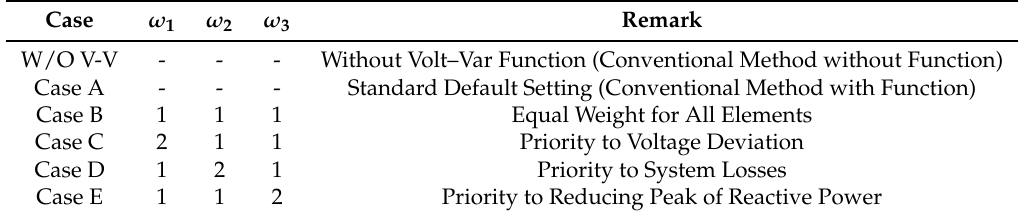
Figure 8. Case Comparison to verify the Improvement Effect on System Losses. Table 3. Case